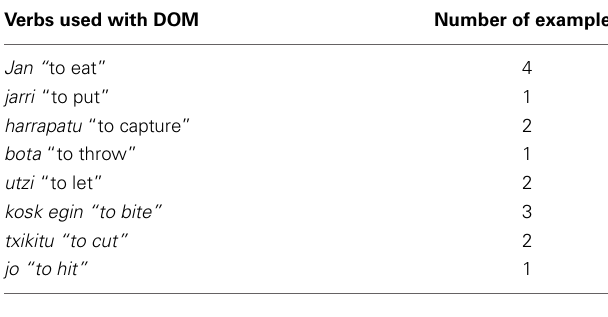
Table 11 | Verbs used with DOM by monolingual children. Verbs used with DOM Number of examples